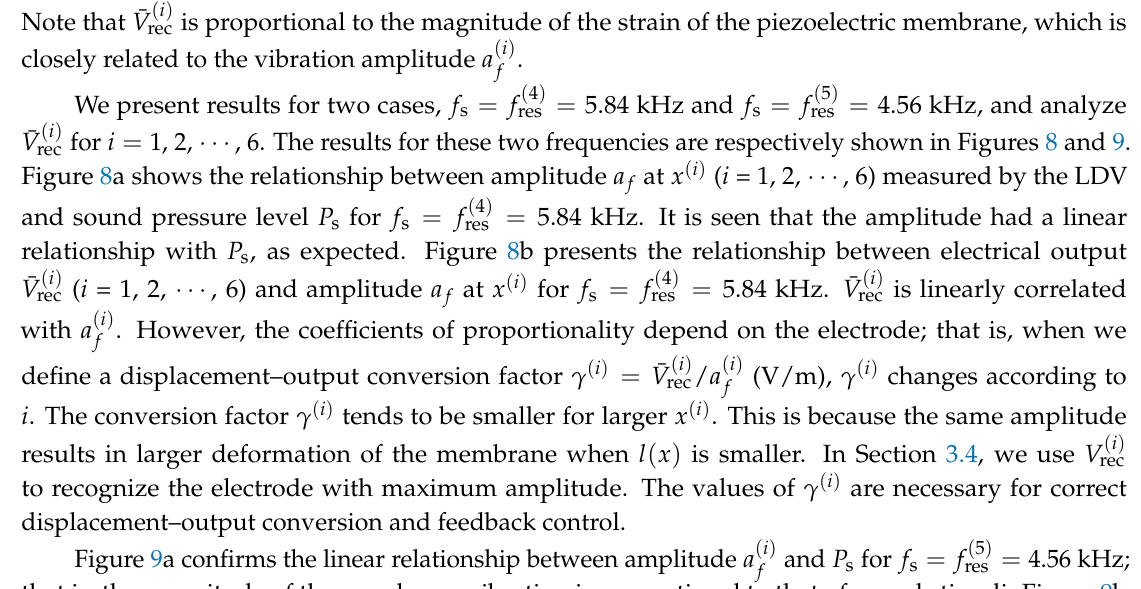
( 5 ) e used in the experiment